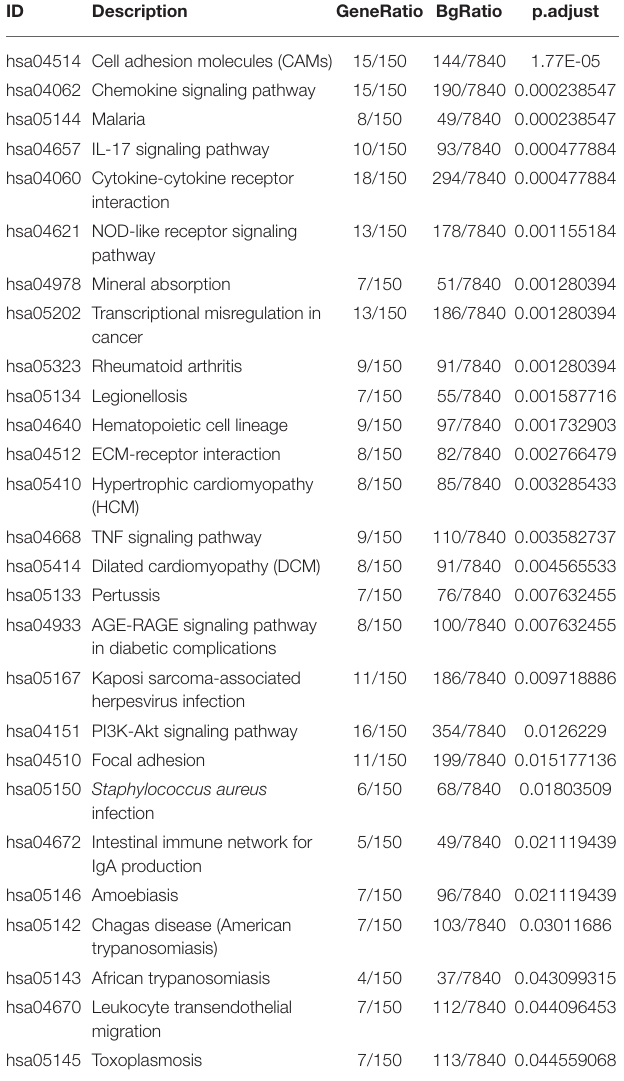
TABLE 3 | KEGG pathway involved in PRAD according to UBASH3B expression